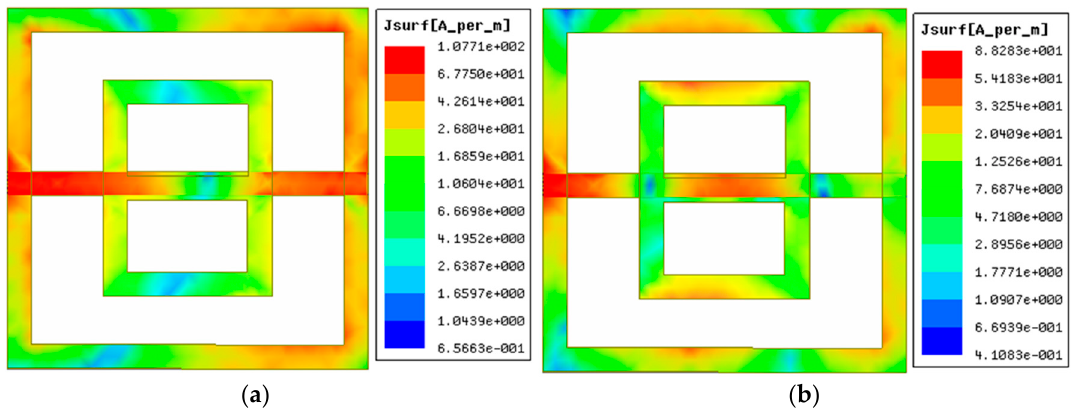
Figure 5. Current distribution of the sensor: ( a ) at 3.0 GHz, and ( b ) at 6.5 GHz.